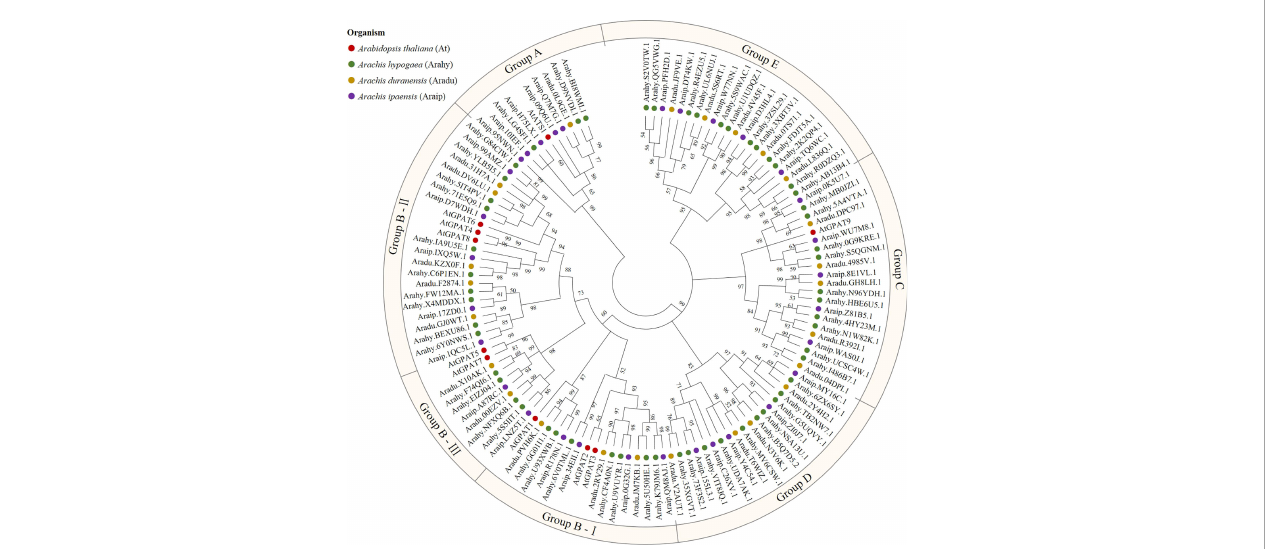
FIGURE 1 Phylogenetic analysis of glycerol-3-phosphate acyltransferase (GPAT) family in peanut. GPATs in cultivated peanut ( Arachis hypogaea ) and its two diploid progenitors ( Arachis duranensis and Arachis ipaensis ), as well as A. thaliana were used to construct a phylogenetic tree by maximum likelihood method with 1000 bootstraps using MEGA software (version X). Red = A. thaliana ; Green = Arachis hypogaea ; Yellow = Arachis duranensis ; Purple = Arachis ipaensis